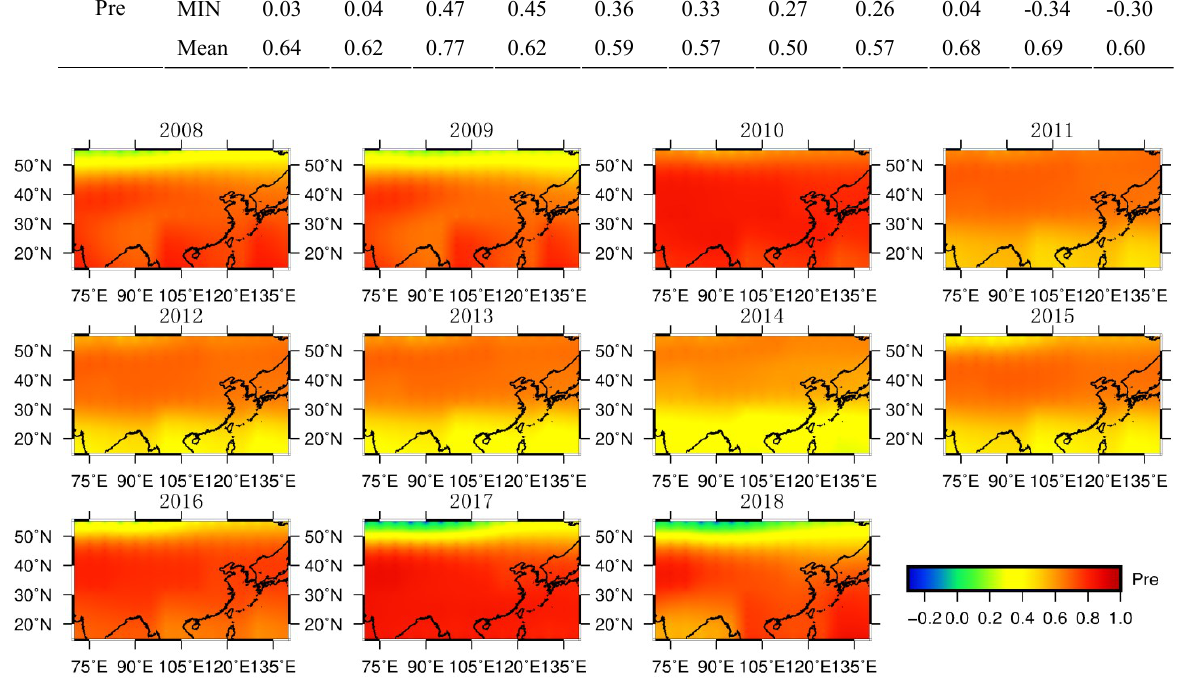
Fig.2 Annual accuracy of the Klobuchar model during high, medium and low solar